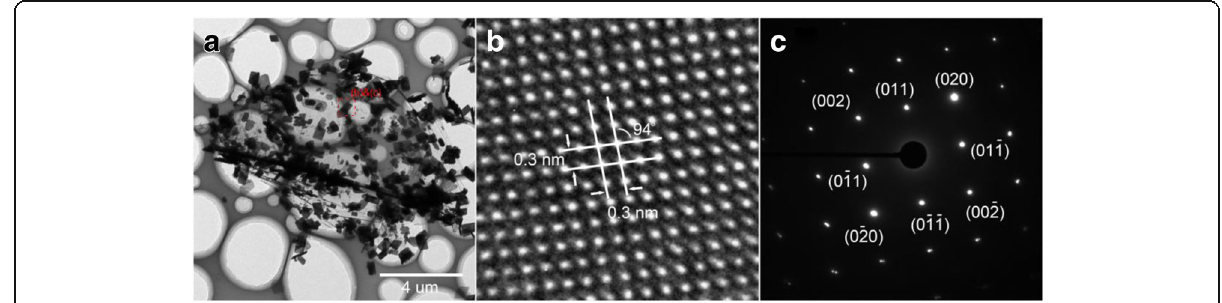
Fig. 3 a The low-magnification TEM image of the representative SnSe nanoplate-graphene nanocomposites; b , c the high-magnification TEM image and SAED pattern of the representative SnSe nanoplate of the rectangular of a ,